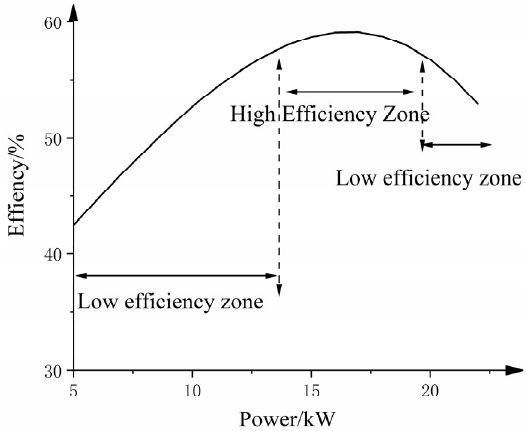
Figure 2. The relationship between output power and efficiency of PEMFC systems.